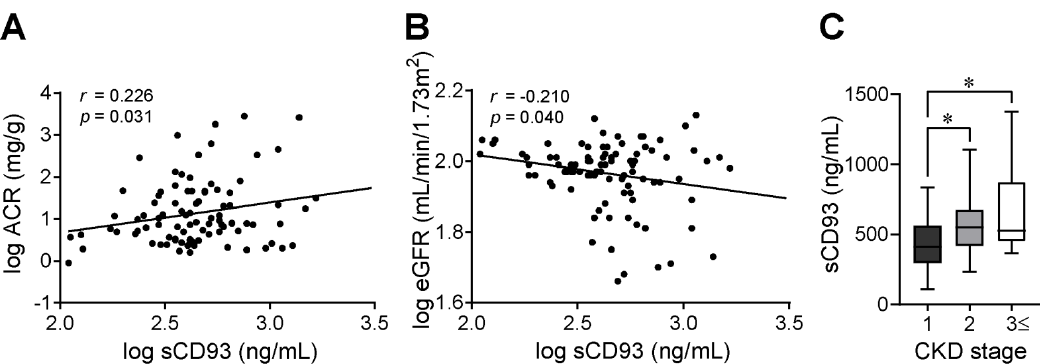
Figure 1. Relationship between serum sCD93 and clinical markers of diabetic nephropathy. All data were log-transformed and the correlations between serum sCD93 and ( A ) the ACR or ( B ) the eGFR were presented with Pearson’s correlation coefficient ( r ). ( C ) A graph showing the levels of sCD93 according to CKD stages. Table 3. Correlations between serum sCD93 and various clinical parameters.